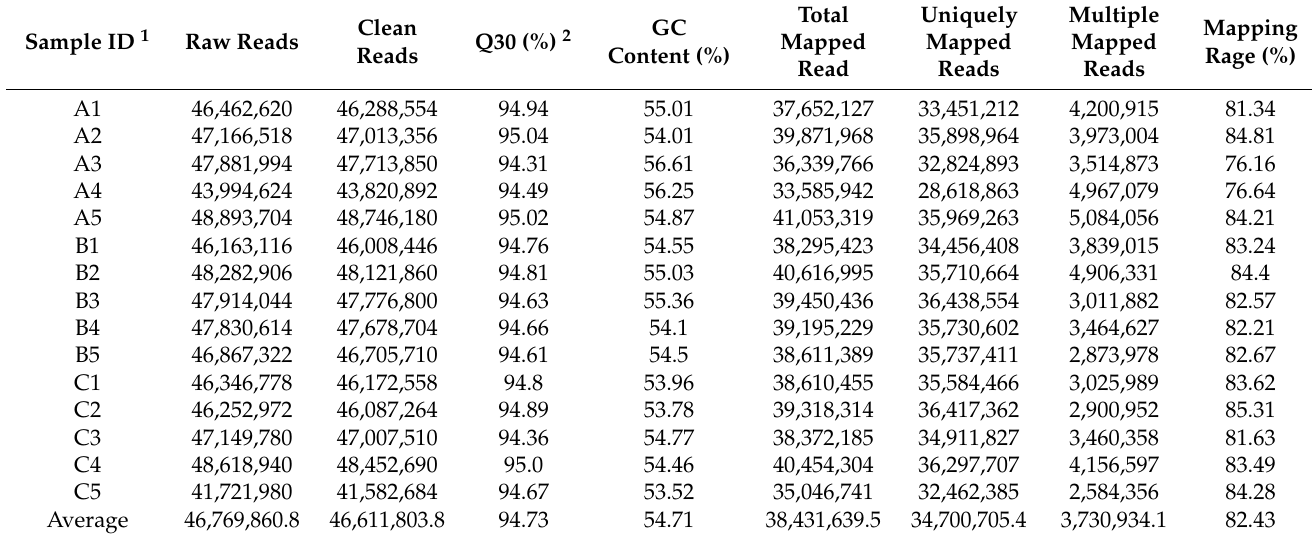
Table 1. RNA-Seq reads and mapping rate of breast muscle samples from 15 chickens fed an experimental